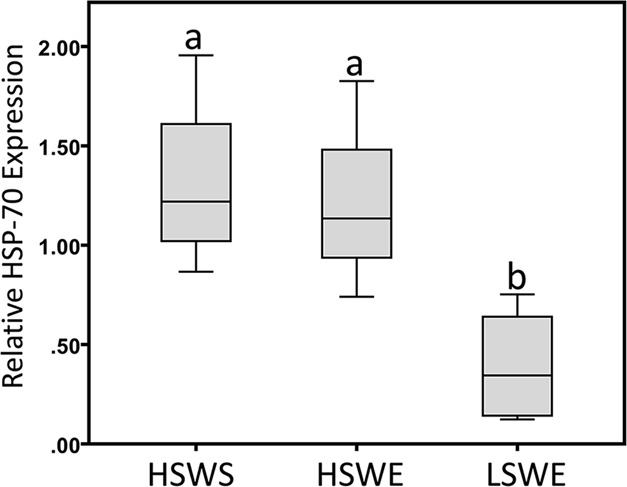
Expression of HSP-70 in Crystal Cove State Park samples. Heat-shock-70 gene expression from mussels (N=4) samples from high-shore-wave-sheltered (HSWS), high-shore-wave-exposed (HSWE) and low-shore-wave-exposed (LSWE) microhabitats. Bars indicate 1 s.e. around the means. A one-way ANOVA followed by Tukey's test identified significant (P<0.05) differences in maximum sizes between groups, as indicated by letters.